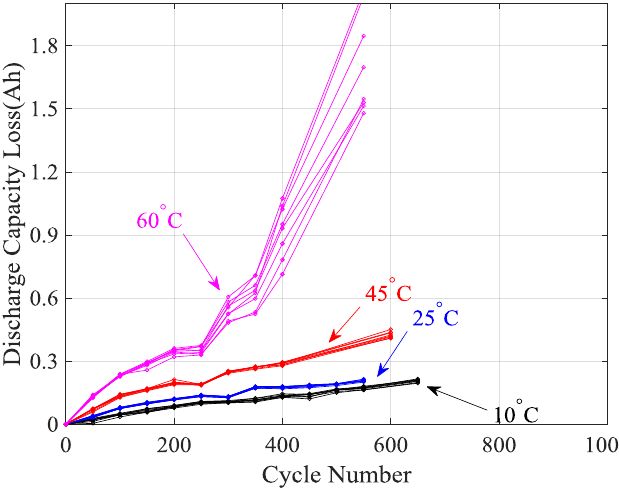
Figure 3. Capacity degradation with cycle number.